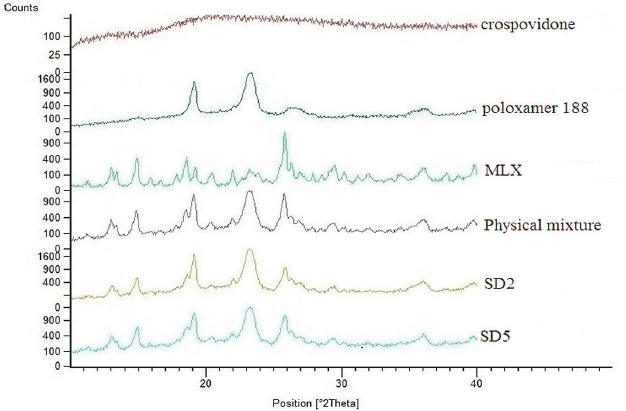
FIGURE 2 - XRD pattern of pure MLX, poloxamer 188, crospovidone, their physical mixture and MLX SDs (SD2 and